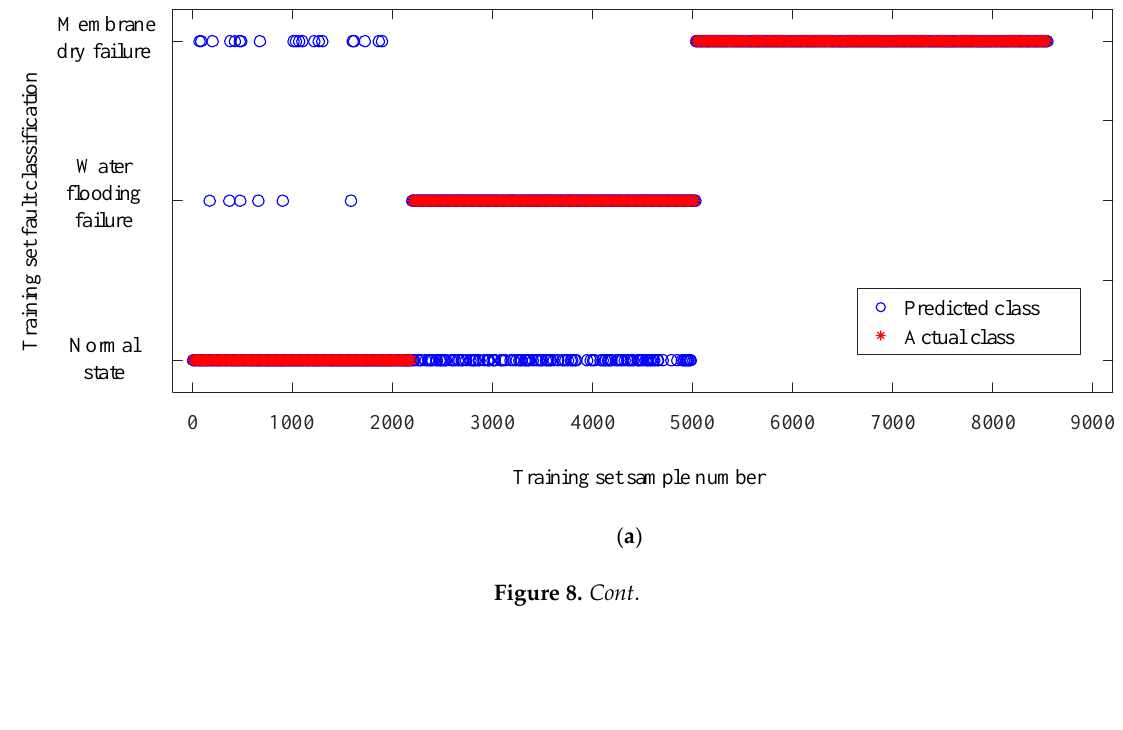
( b ) Figure 8. Diagnostic results of KPCA-LVQNN. ( a ) Training diagnostic results; ( b ) test diagnostic results. In order to better describe and analyze the diagnosis results, false alarm rate (FAR) and false rejection rate (FRR) are used to further analyze the diagnosis results. The FAR is defined as the percentage of the samples that are misdiagnosed as fault state in the total samples of normal state, and the FRR is defined as the percentage of the samples that are misdiagnosed as normal state in the total samples of fault state. The FAR of the KPCA-LVQNN training set is 1.28%, and the FRR is 2.80%. The FAR of test set is 2.05%, and the FRR is 3.42%. It can be found that a small number of normal states are misjudged as flooding and membrane dry fault, and some flooding fault cannot be diagnosed with KPCA-LVQNN. The reason is that the degree of water flooding and membrane dry fault in this part is relatively slight, and the reduction of voltage is relatively small, which is similar to the experimental data in normal state. A confusion matrix is used to visualize the prediction effect, which is usually used in supervised learning. The total number of each column of the confusion matrix represents the total number of samples predicted for the category, and each row represents the ac- tual total number of samples for the category. The confusion matrix of the training set and test set samples are shown in Figure 9. 0